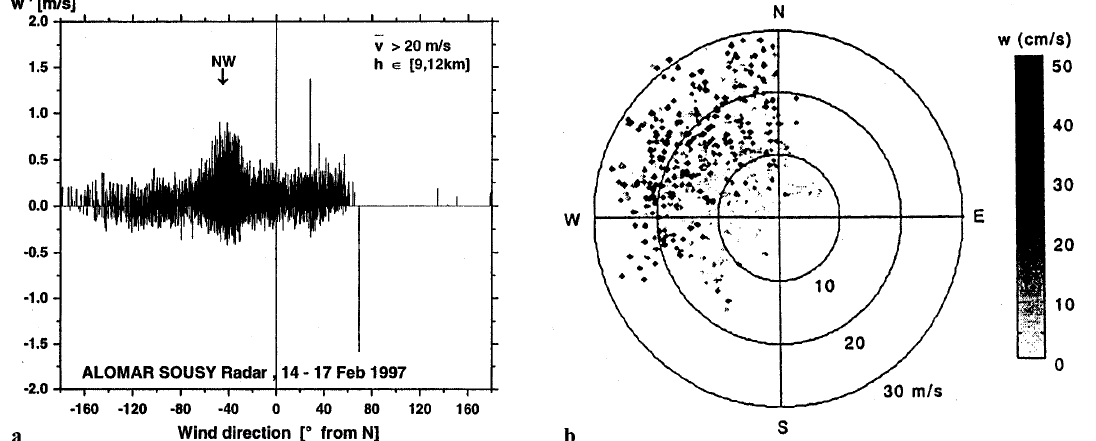
Fig. 7. a Dependence of vertical wind variations on the direction of the horizontal wind near the tropopause (9–12 km) observed 14–17 February, 1997, with the ALOMAR SOUSY radar in Norway (after